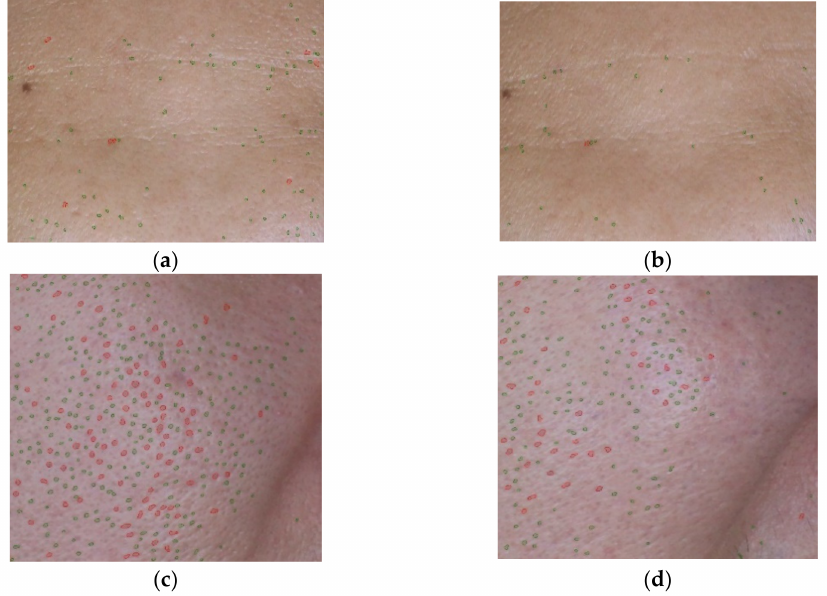
Figure 4. An example of pore area visualization from the A. racemosus Willd. root extract solution treatment using VisioFace ® CSI software (Köln, Germany) ( a ) before and ( b ) after 30 days of the extract treatment on forehead; ( c ) before and ( d ) after 30 days of the extract treatment on right cheek. Red spots = large pores; green spots = fine pores.